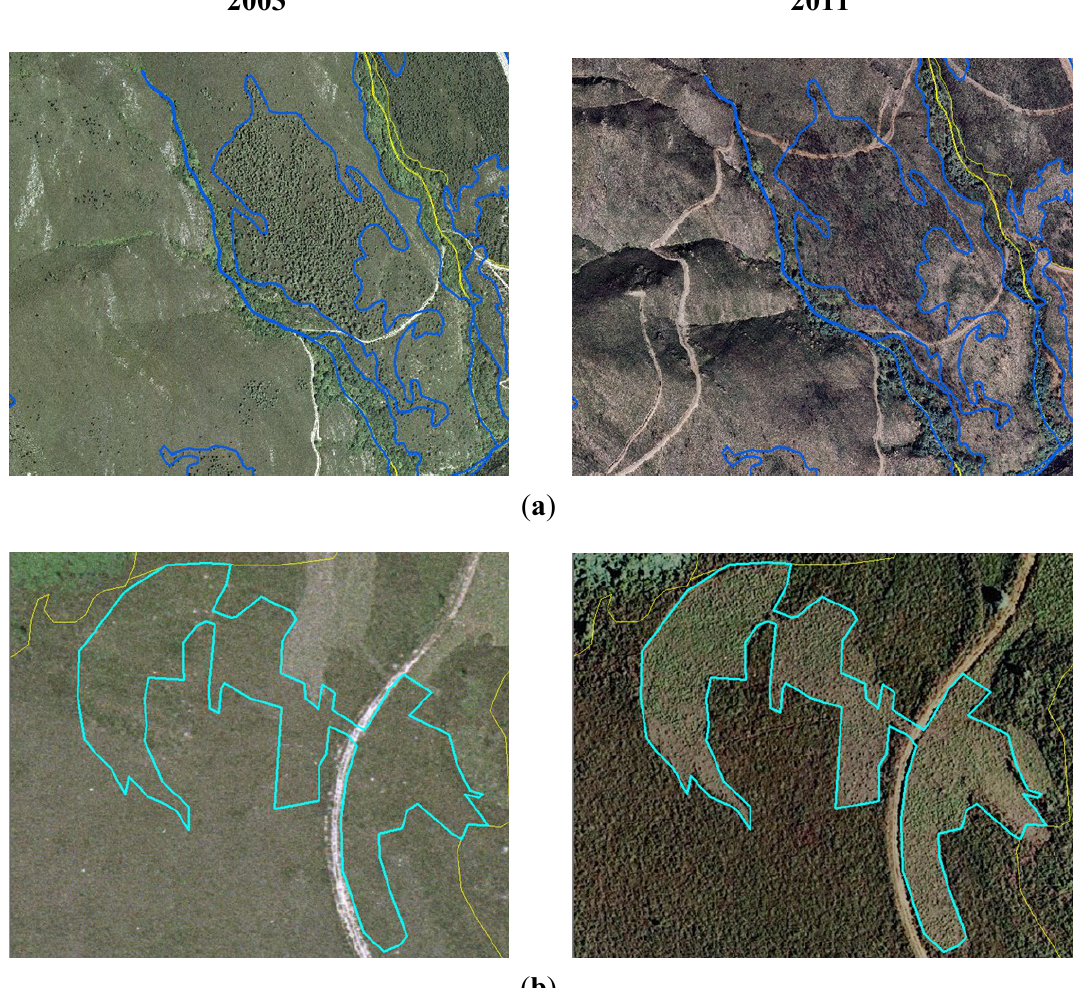
Figure 5. Examples of degradation of the structure of the habitat type European dry heaths (Nat-2000 4030) in the study area during the period 2003–2011. ( a ) wildfires; (b ) brushing